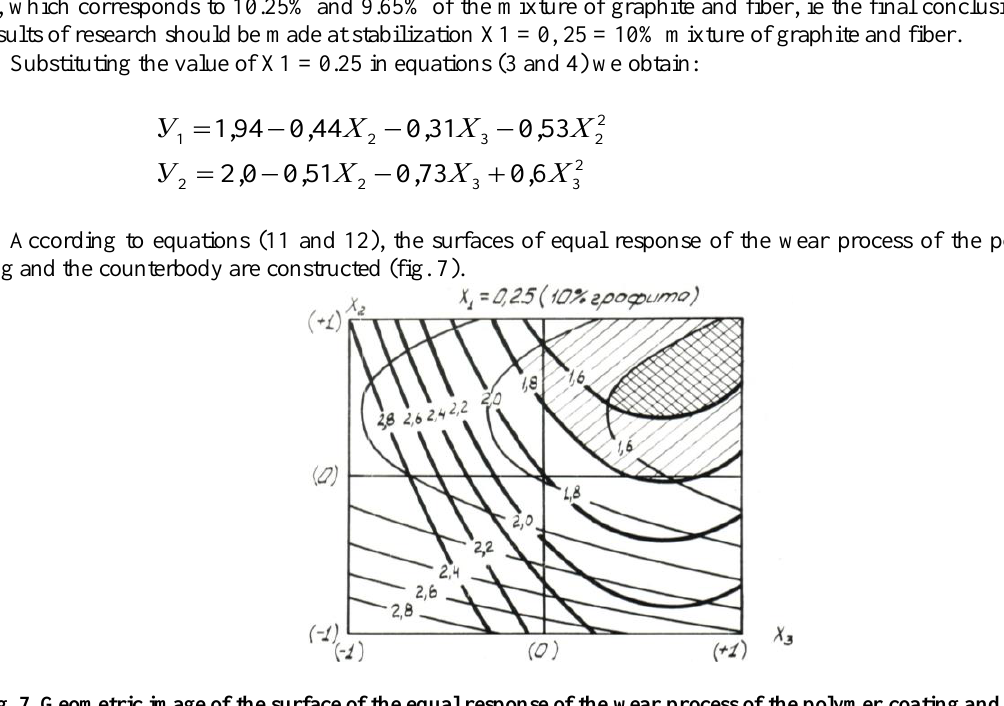
Fig. 7. Geometric image of the surface of the equal response of the wear process of the polymer coating and the